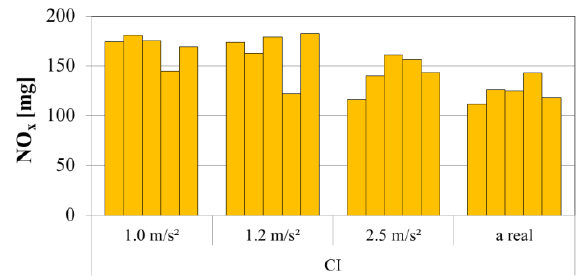
Fig. 18. NO x emission for different acceleration characteristics of a vehicle propelled with CI Euro 3 engine obtained during simulation using PTV